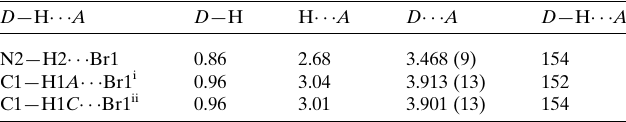
Table 2 Hydrogen-bond geometry (A˚ , (cid:4) ) for AmBr